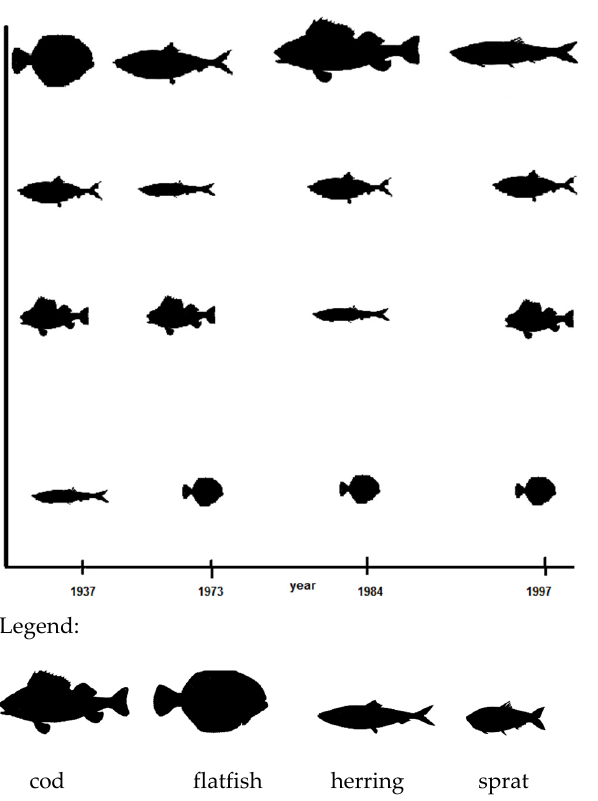
Figure 9. The structure of marine fish catches (including sprat, herring, cod, and flatfish) in the Polish fishery over time (from the top—the most often caught), based on [128–135].